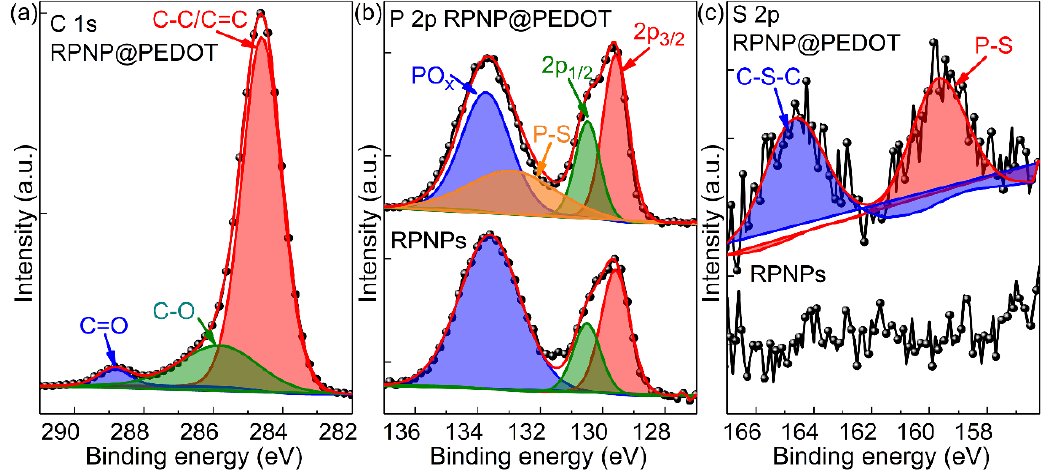
Figure 4. XPS spectrum of RPNPs and RPNP@PEDOT: ( a ) C 1s, ( b ) P 2p, and ( c ) S